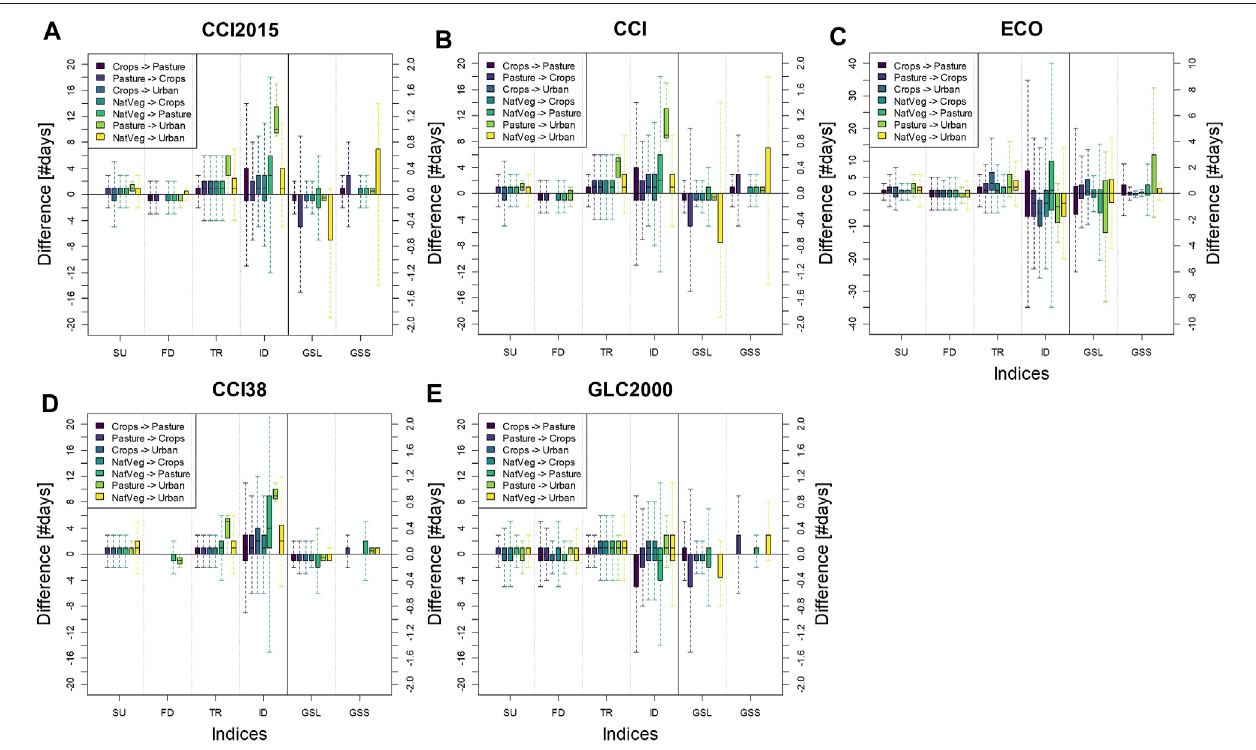
FIGURE12| DifferencesofclimateindicesindaysduetolandcoverchangebetweenCCI2015andGC (A) ,CCIandGC (B) ,ECOandGC (C) ,CCI38andGC (D) , and GLC and GC (E) for the time period from 2002 to 2011. Cropland grid cells change into pasture type (purple), pasture grid cells change into cropland (dark blue), cropland grid cells change into urban type (blue), natural vegetation grid cells change into crop type (dark green), natural vegetation grid cells change into pasture type (green), pasture grid cells change into urban type (light green), and natural vegetation grid cells change into urban type (yellow). Differences are calculated for grid cells, where the listed land cover type change occurs. The climate indices are Summer Days (SU), Frost Days (FD), Tropical Nights (TR), Ice Days (ID), Growing Season Length (GSL), and Growing Season Start (GSS). Please see Table 1 for abbreviations of simulation experiments.